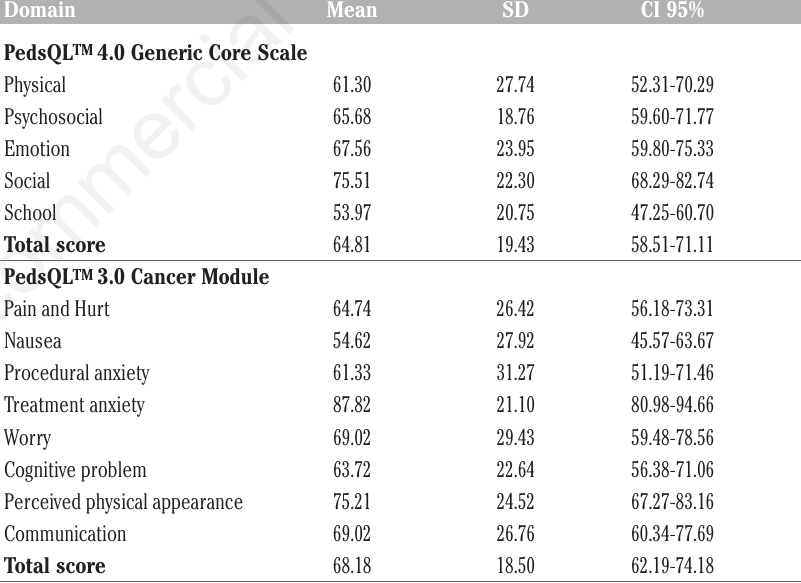
Table 2. Overview of total scores and subscale of PedsQL TM 4.0 Generic Core Scale and PedsQL TM 3.0 Cancer Module.